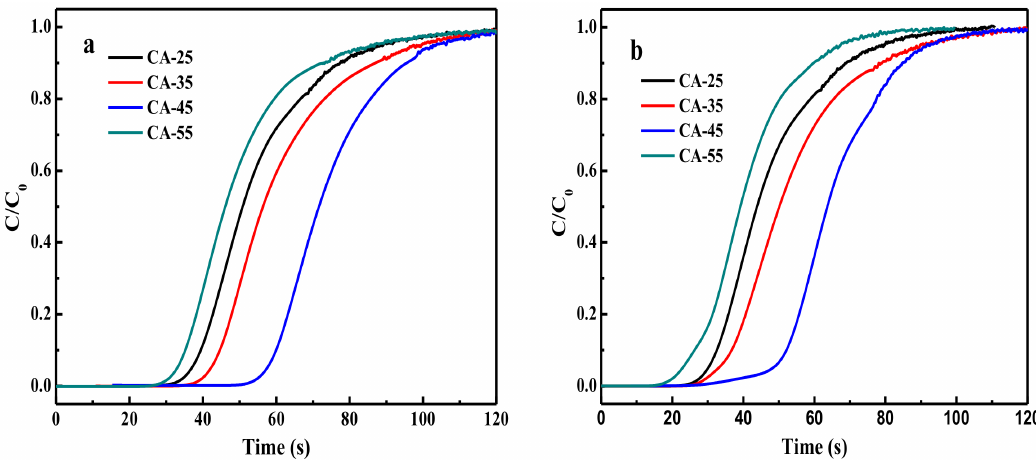
Figure 8. CO 2 breakthrough curves of CA-X samples under ( a ) dry and ( b ) humid